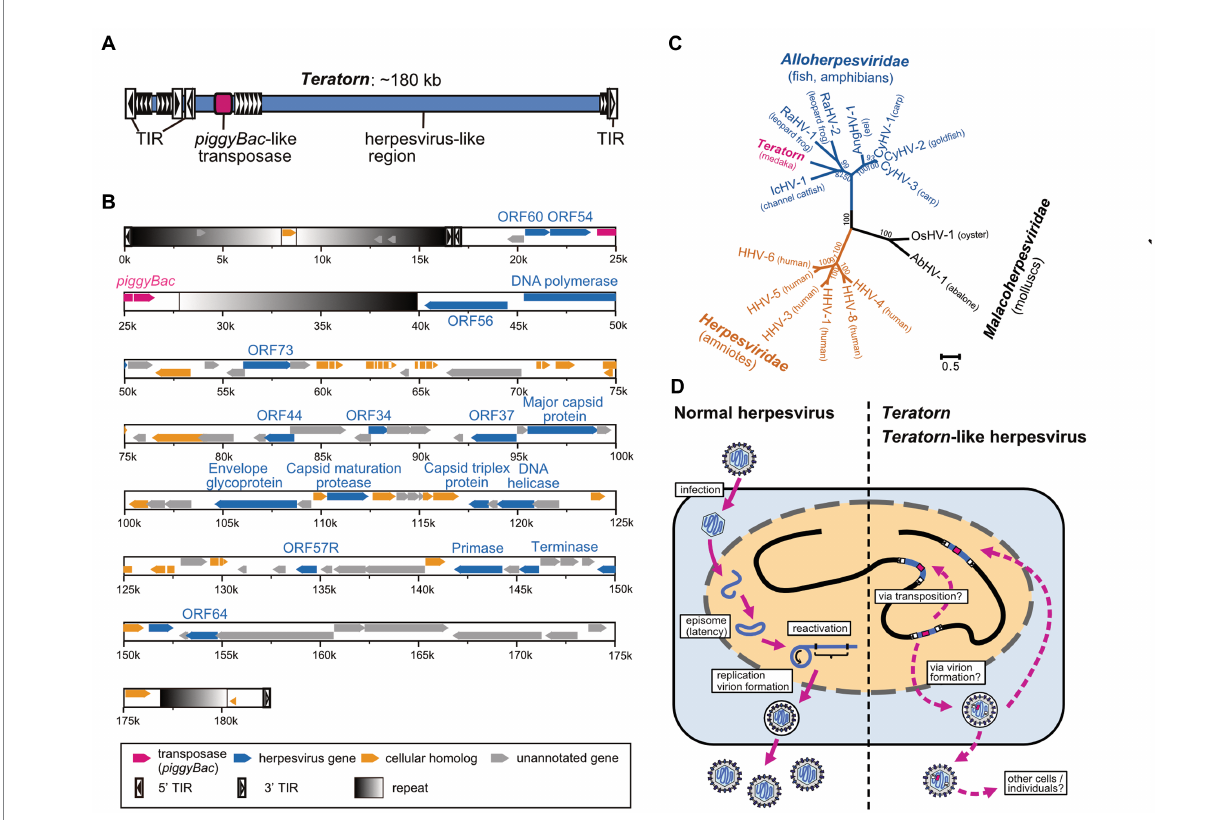
FIGURE 2 Sequence characteristics of Teratorn and its proposed life cycle. (A) The overall structure of Teratorn . (B) Gene map of the subtype 1 Teratorn copy. Predicted genes are classified into four categories depicted by colored arrowheads; magenta, PiggyBac -like transposase gene; blue, herpesvirus-like genes; yellow, cellular homologs; gray, unannotated genes. Terminal inverted repeats (TIRs) of PiggyBac -like transposon are depicted by squares with black-to-white gradients. (C) Phylogeny of Teratorn and representative herpesvirus species, based on the maximum-likelihood analysis. Amino acid sequences of the DNA packaging terminase, the only gene confidently conserved among all herpesvirus species, were used. Bootstrap values of branching are indicated at the nodes. (D) Comparison of life cycles of normal herpesviruses (left) and Teratorn